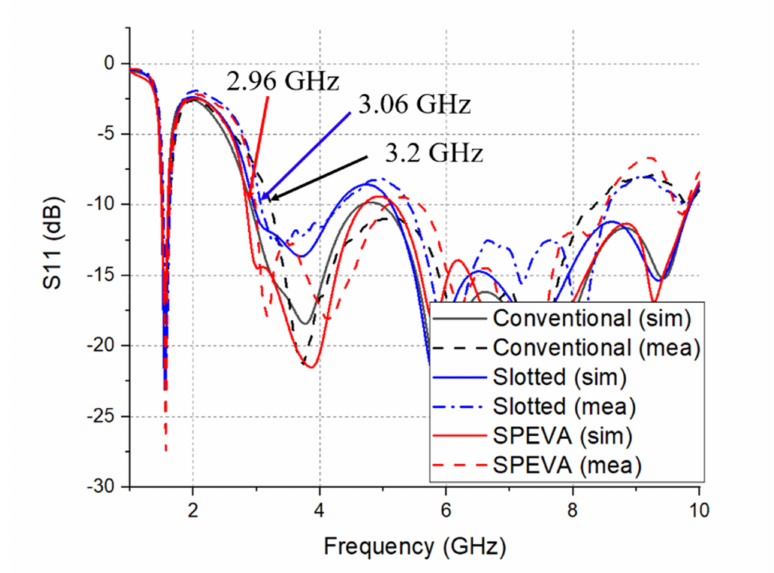
Figure 5. Simulated ( a ) S 11 and ( b ) realized gain of SPEVA with the di ff erent value of Gap.